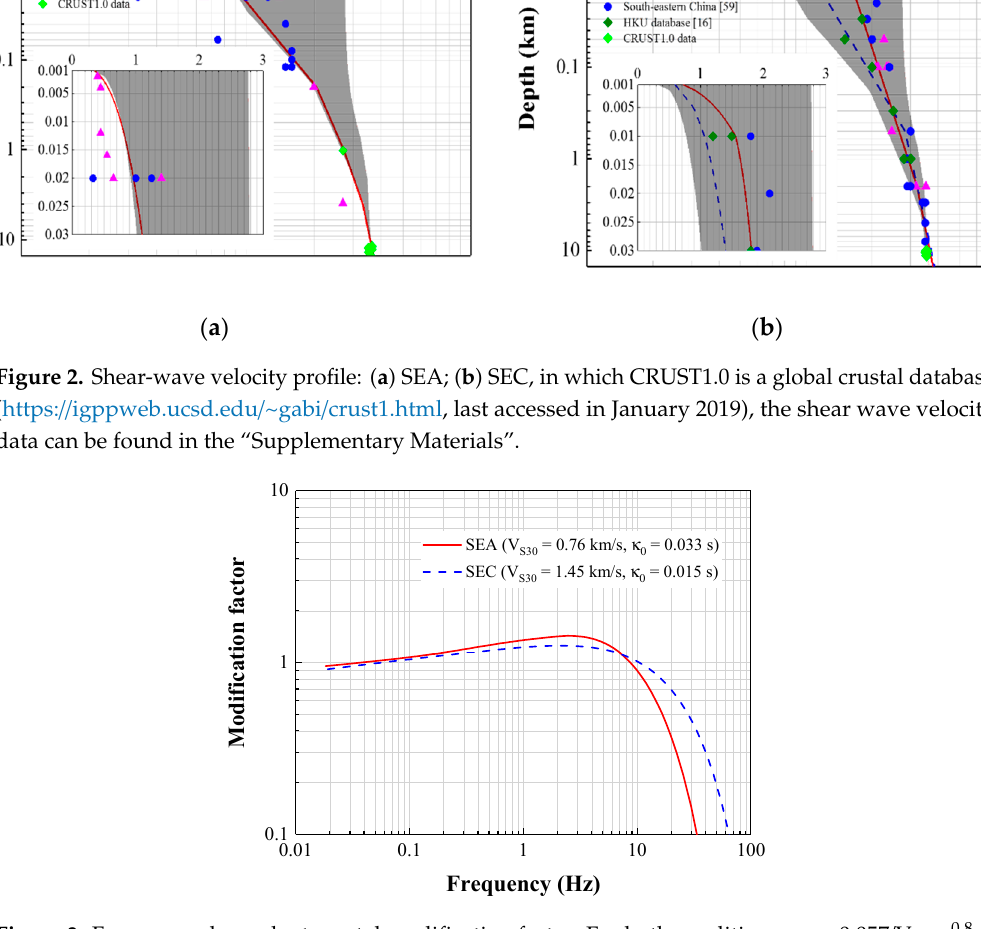
Figure 3. Frequency-dependent crustal modification factor. For both conditions, κ 0 = 0.057 / V s0.030.8 − 0.02 [42,43].